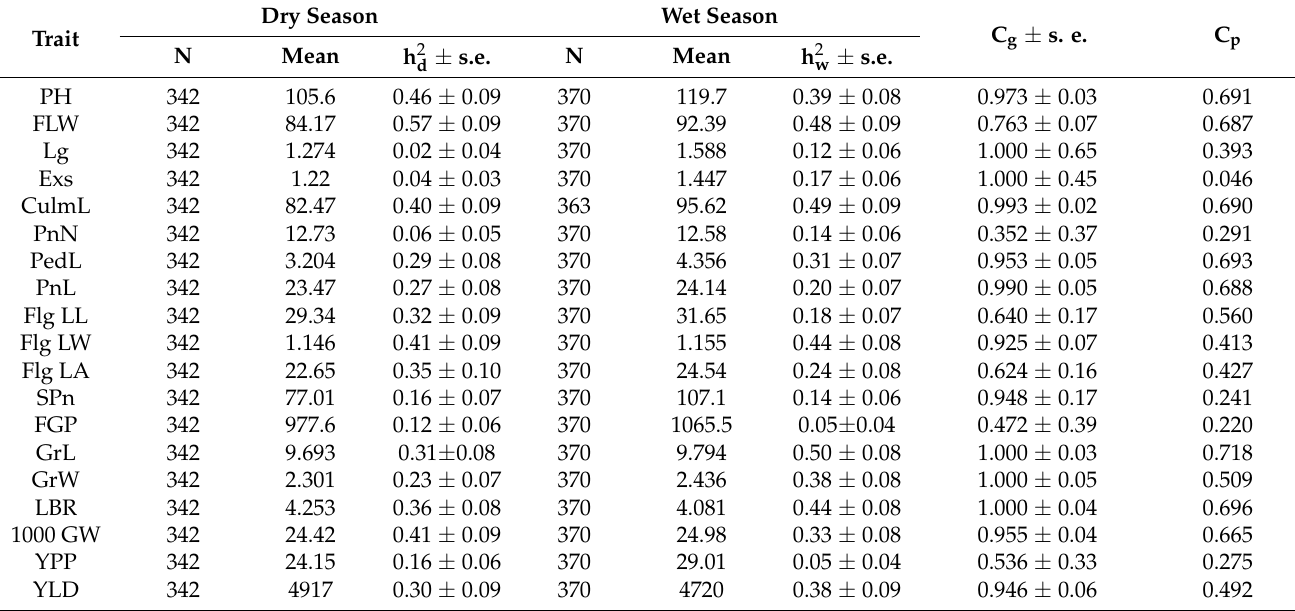
Table 1. Descriptive statistics and estimated genetic parameters for all measured traits.